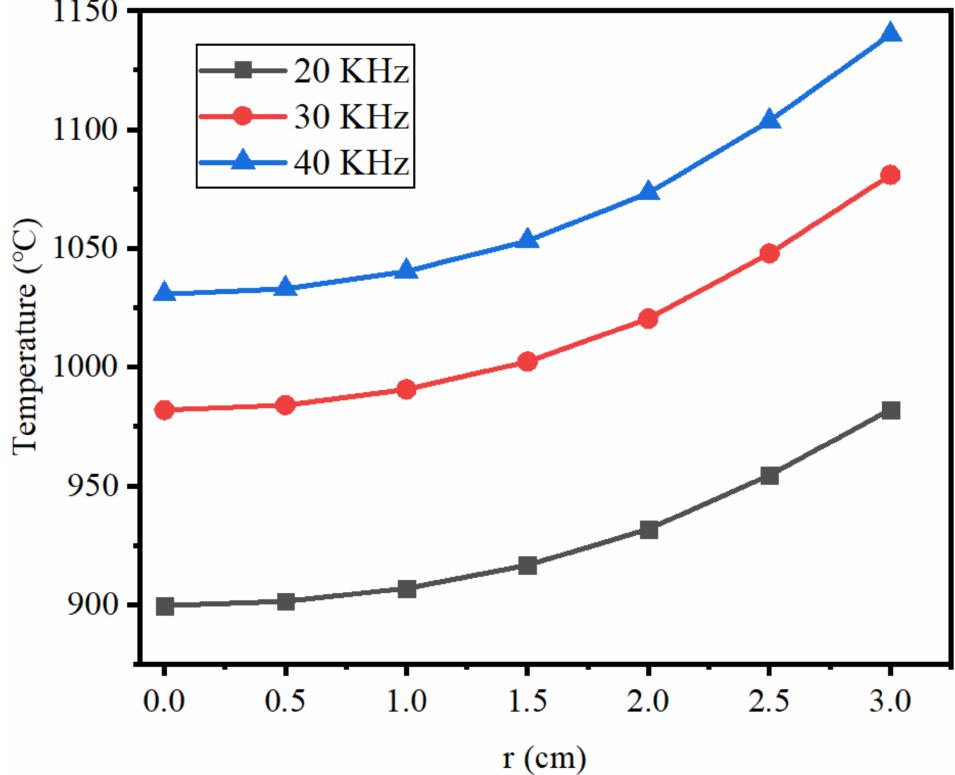
Figure 6. Radial temperature distribution of molten